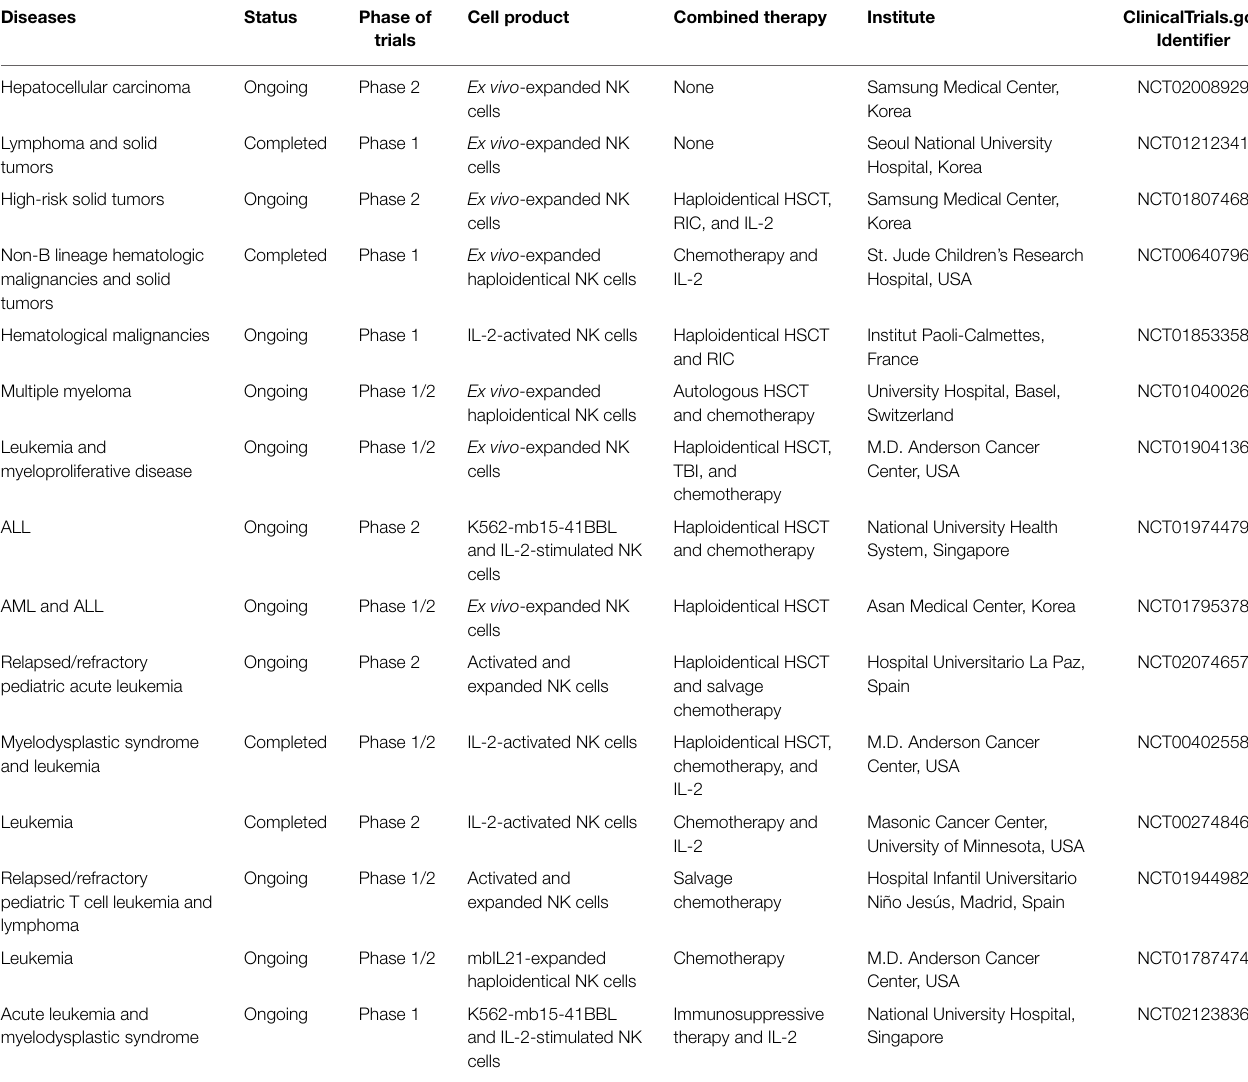
TABLE 1 | Selected clinical trials with expanded allogeneic NK cells